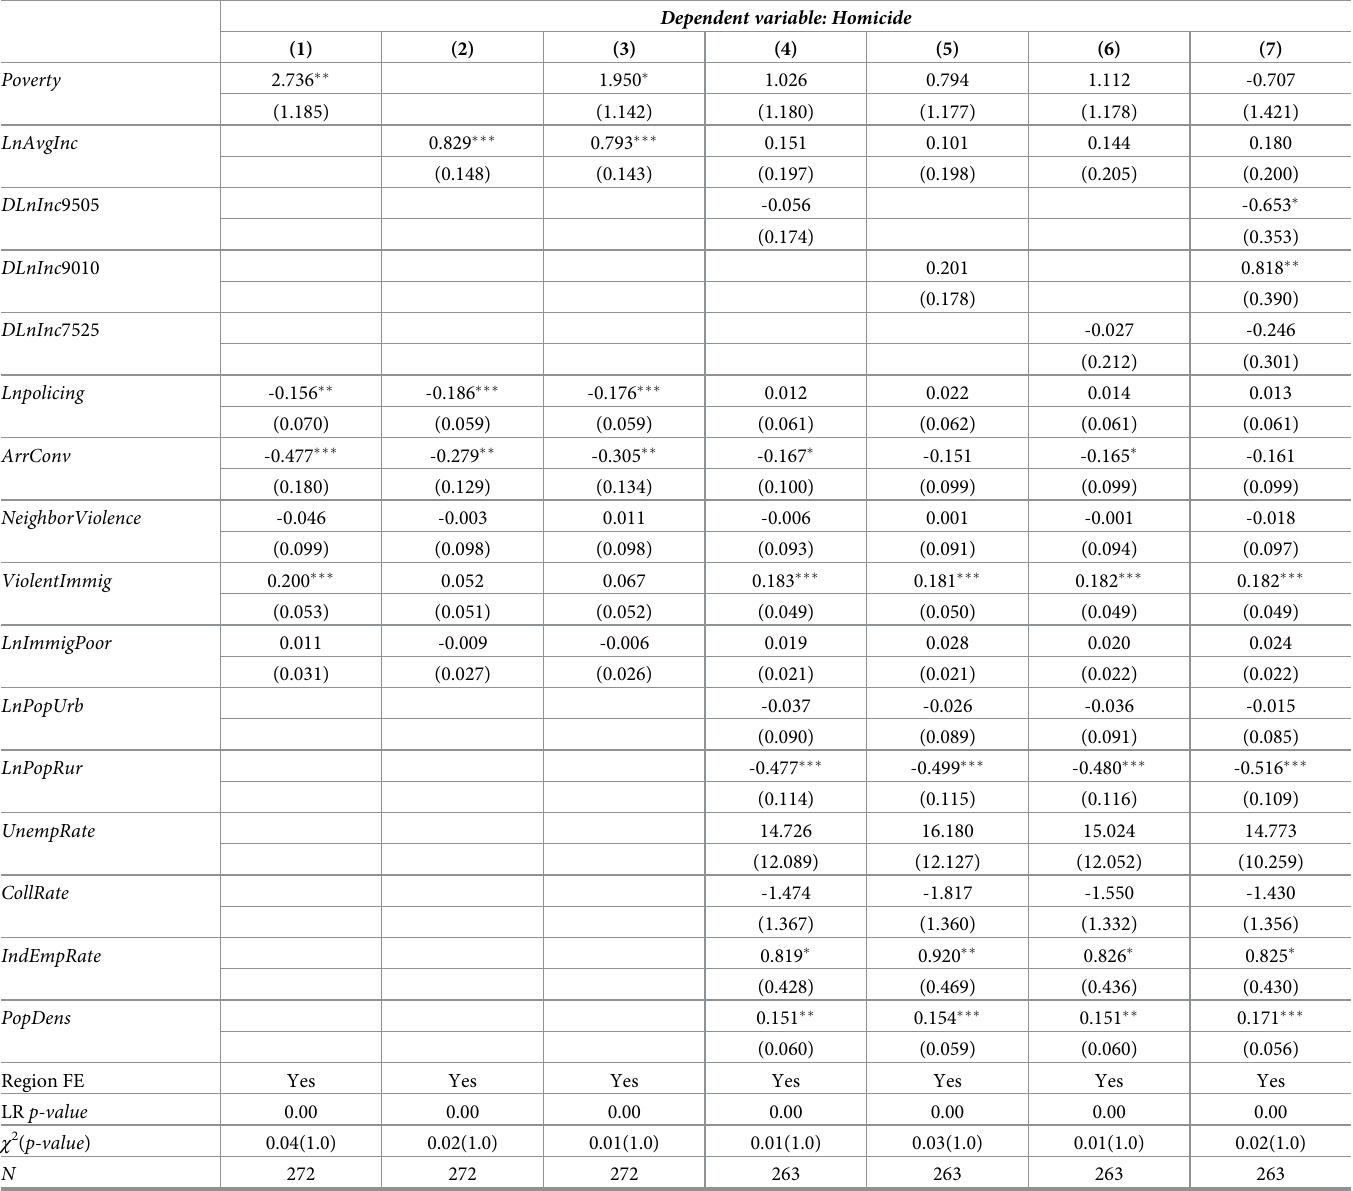
Table 3. The effect of poverty level and income inequality on